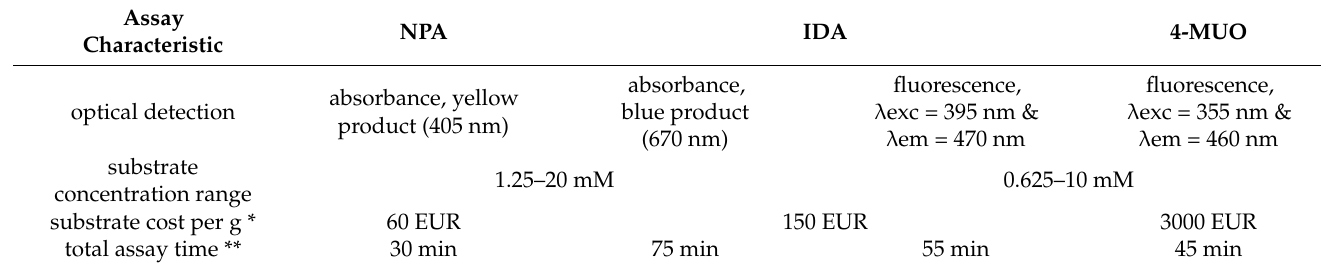
Table 1. Critical comparison of the application of NPA, indoxyl acetate (IDA), and 4-MUO as the substrate. The same PNLIP concentration was used (1250 µ g mL − 1 ) in all cases to provide comparable